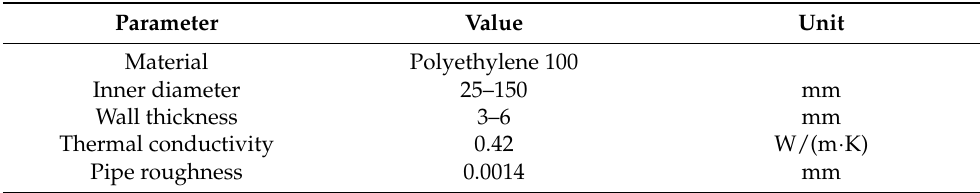
Table 1. Properties of the pipe system. Parameter Value Unit Material Polyethylene 100 Inner diameter 25–150 mm Wall thickness 3–6 mm Thermal conductivity 0.42 W/(m · K) Pipe roughness 0.0014 mm